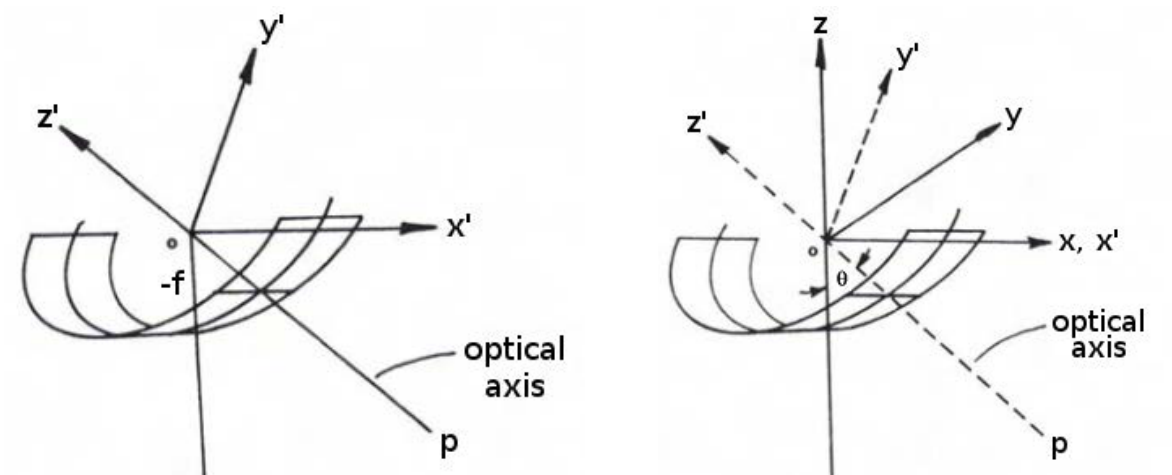
Figure 7: The scan angle θ rotates the instantaneous coordinate system on the left into the local nadir coordinate system on the right. From Jackson et al. (1982).